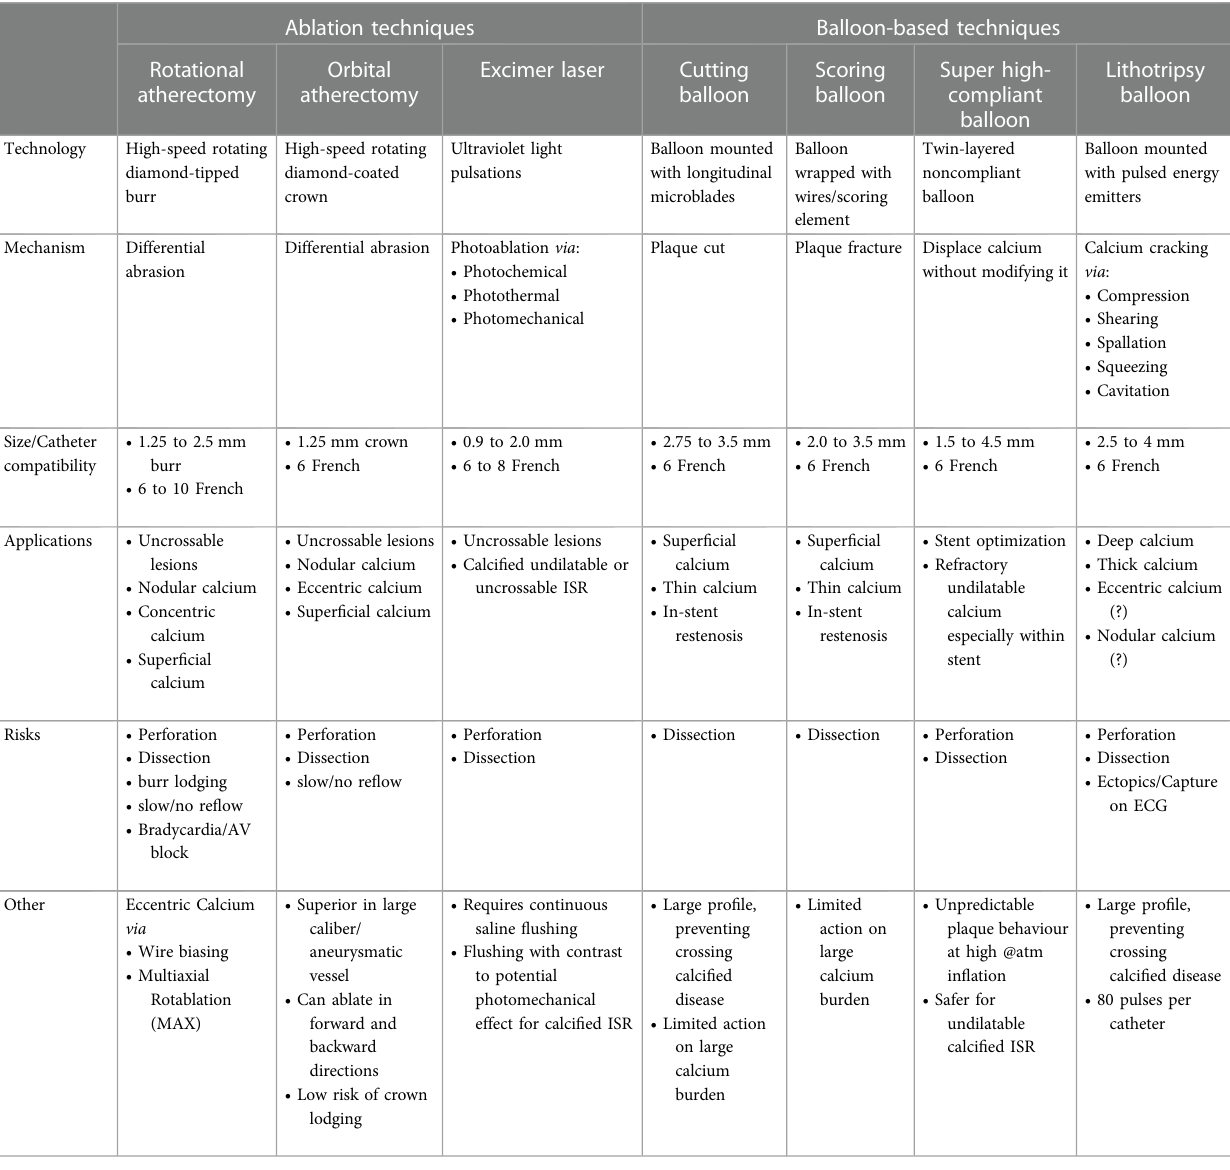
TABLE 1 Summary of coronary artery calci fi cation lesion modi fi cation